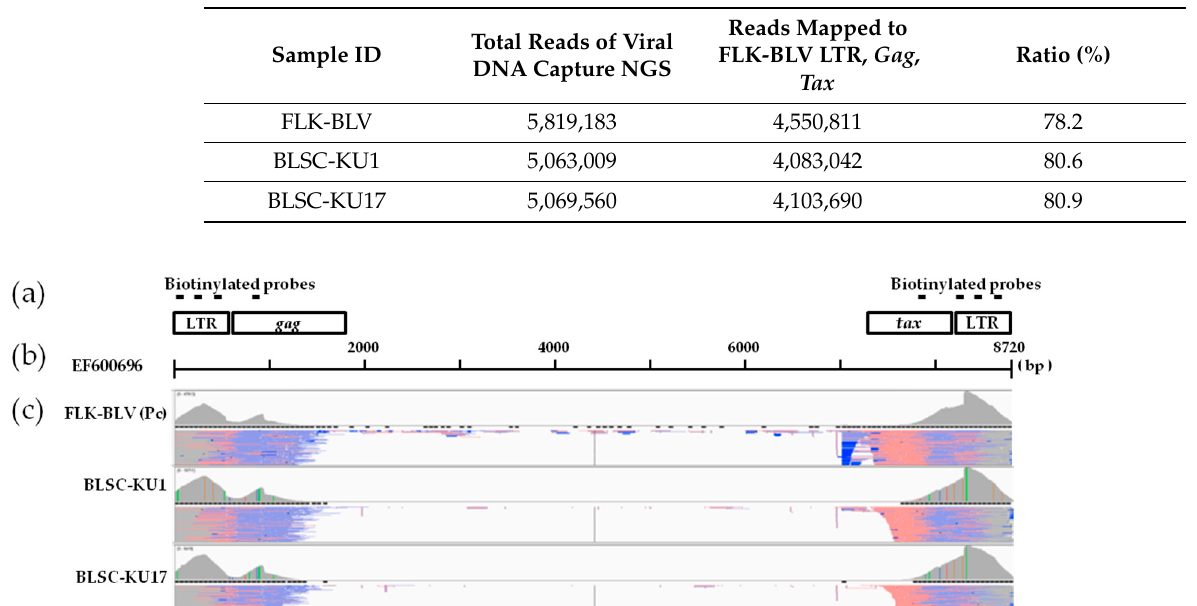
Figure 4. Visualization of BLV integration sites (ISs) in FLK − BLV cells. ( a ) Visualization of NGS reads mapped to the ovine genome around the ISs. The arrow − head indicates the location of the IS. Sequences of virus − host chimeric reads next to the end of BLV gnome are indicated as host − left and host − right; respectively. ( b ) Confirmation of detected ISs by conventional PCR. Host indicate ovine FLK cellular genome, the upside − down writing of BLV provirus and LTR indicates that negative strand BLV provirus was integrated. M, molecular weight marker (100 − bp DNA Ladder). Numbers besides DNA ladder indicate ladder size. Numbers with arrows in red indicate the target PCR prod- uct length. ( c ) Detailed information of ISs in FLK − BLV cells.